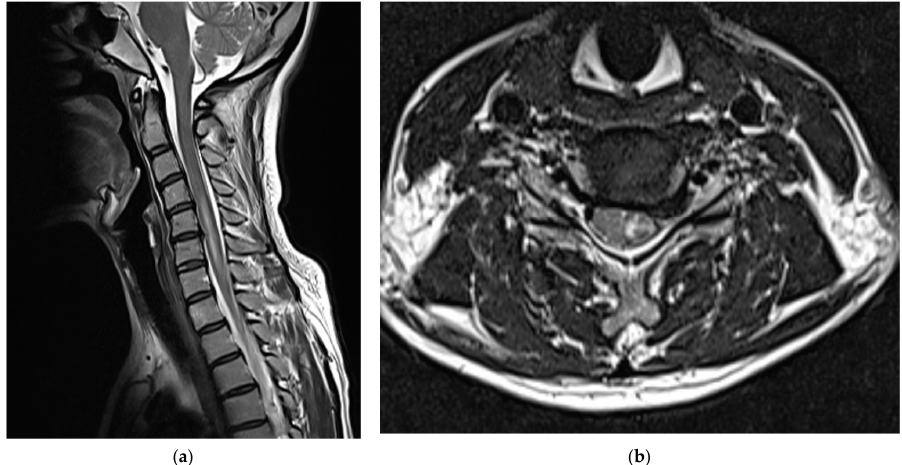
Figure 3. Cervical spine magnetic resonance images obtained on the second day of the procedure Figure 4. Cervical spine magnetic resonance images obtained 6 months after the procedure: ( a ) T2- showed intramedullary T2 high signal intensity and cord swelling from C4/5 to C6/7 levels, which weighted sagittal image and ( b ) T2-weighted axial image of the C5/6 level. The extent of the left central led to the diagnosis of a spinal cord injury: ( a ) T2-weighted sagittal images and ( b ) T2-weighted axial images of the C5/6 level. intramedullary T2 high signal intensity (elongated lesion in the spinal cord) from the C4/5 to C7 levels slightly reduced. The spinal cord swelling is also After confirming the findings of the cervical spine MRI, drug treatment was initiated with steroid pulse therapy (intravenous methylprednisolone 1 g daily), pregabalin 75 mg twice daily, duloxetine 30 mg once daily, and tramadol/acetaminophen 75/650 mg twice daily. As the symptoms of PDPH nearly resolved at 48 h after the procedure, an epidural blood patch was not performed. The above-mentioned drugs, including steroids, were continued for another two weeks. After 2 weeks, the manually tested left upper extremity muscle power recovered slightly to 3/5 proximally and 4/5 distally, with a slight improve- ment in sensory change; gait disturbances were not observed. Therefore, the patient opted to be followed up on an outpatient basis. Medications, excluding steroids, were continued for 1 month after the procedure. The patient reported that their left upper arm motor weakness improved slightly (4/5); how- ever, sensory changes persisted. Two months after the procedure, shoulder strength was almost fully restored (5/5), left-hand motor weakness slightly improved further (4/5), and sensory function had almost returned to normal; however, the patient complained of per- sistent paresthesia in her left hand. At 3 months after the procedure, her left-hand motor weakness showed almost complete recovery (5/5); however, abduction of her fifth finger diminished to 4/5, and the decreased sensation in the dorsum of the left hand persisted. Six months after the procedure, abduction of the fifth finger continued to decrease and sensory deterioration in the dorsum of the left hand remained. As detected during the follow-up MRI performed 6 months post-procedure, the T2 high signal intensity in the left central intramedullary region decreased compared to that observed previously; however, spinal cord swelling was still present, albeit reduced (Figure 4). In addition, left C7/8 radiculopathy with acute denervation was confirmed by elec- tromyography that was performed at 6 months after the procedure.